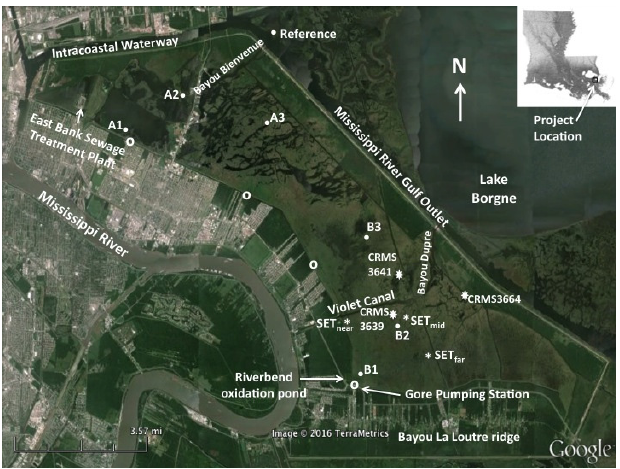
Figure 1. Location of the Central Wetlands Unit (CWU) and primary features. “o” indicates stormwater pumping stations. The study was carried out in three sub-units of the CWU. Sampling sites A1 and A2 are located between the East Bank Sewage Plant and a highway embankment. Sites A3 and B3 are located between the highway embankment and Violet Canal. Sites B1 and B2 are located south of Violet Canal. Sites identified with a sediment elevation table (SET) are where wetland surface elevation change and accretion were measured.